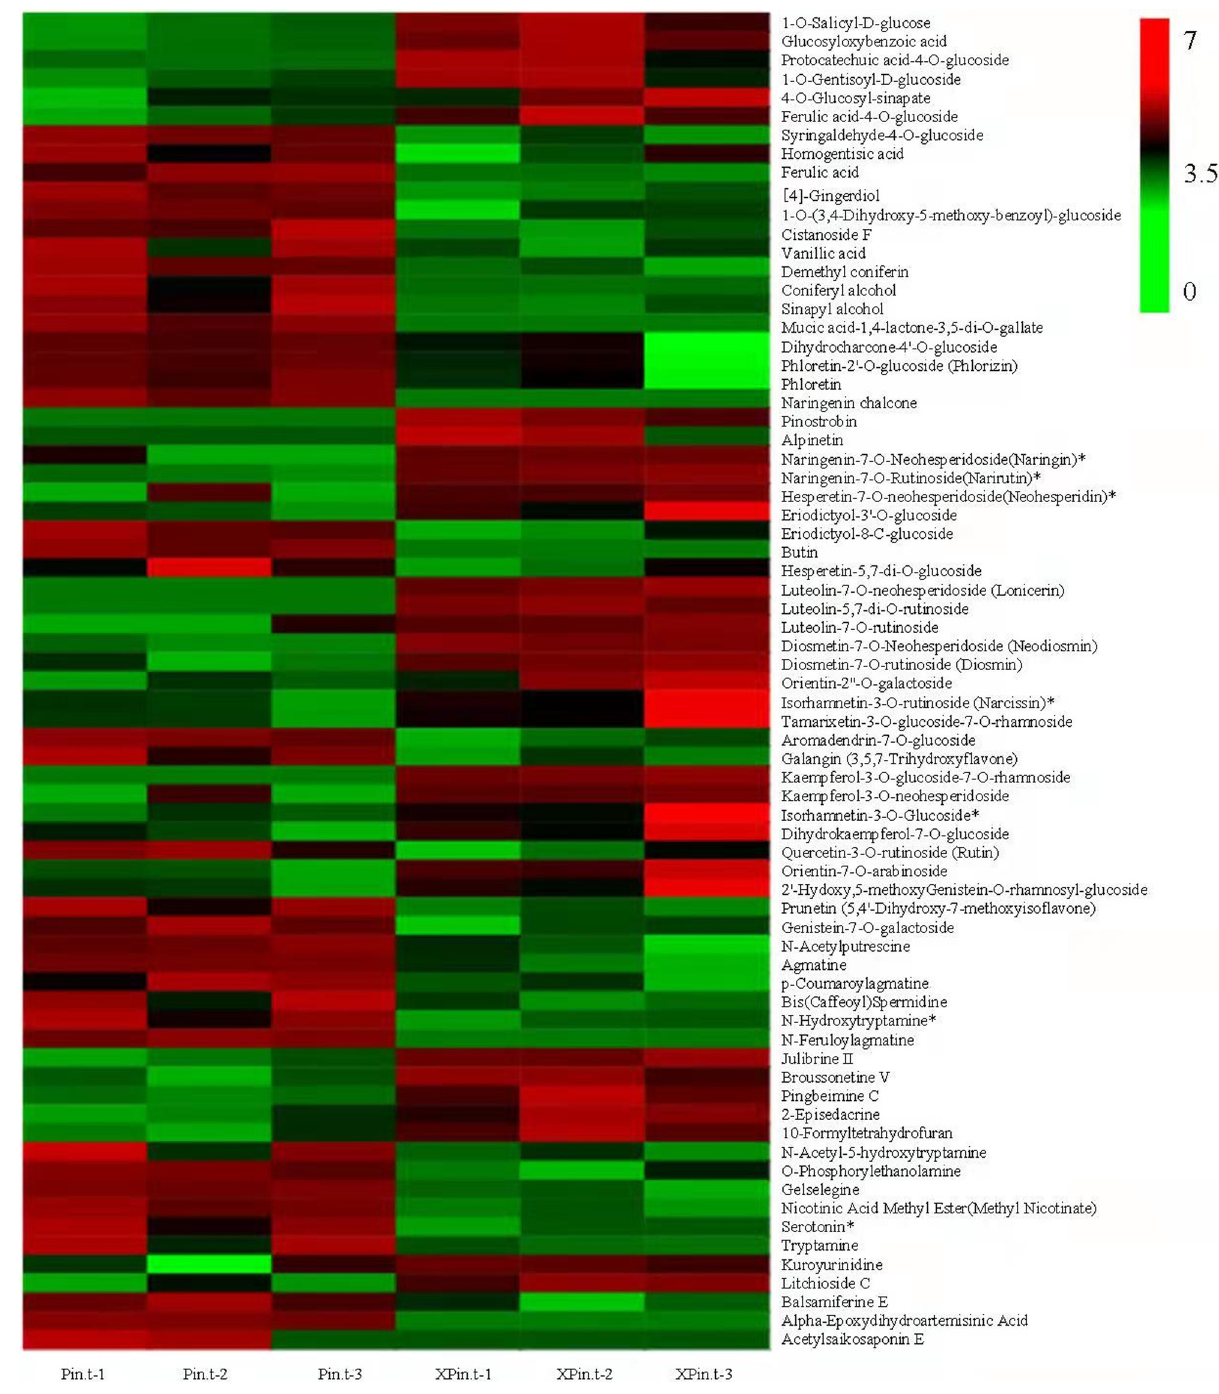
Figure 5: The heatmap depicting the main di ff erentially accumulated secondary metabolites between Pin.t and